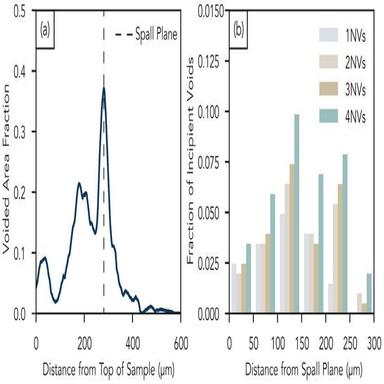
(a) Voided area fraction as a function of distance from the top of the sample. (b) Fraction of the incipient (1-4 neighbor) voids as a function of distance from the spall plane – note that there are no 1NVs far from the spall plane, and that 1-4NVs drop off close to the spall plane due to the increasing amount of void coalescence causing higher-order voids.